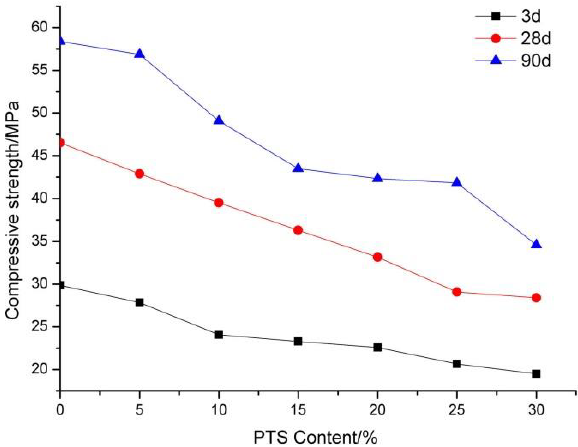
Figure 14: Compressive strength development of cement with tail- ings